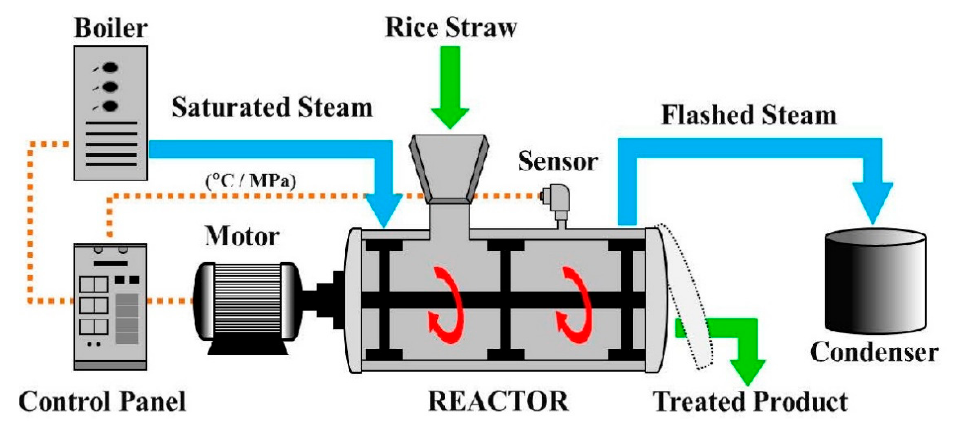
Figure 1. Schematic diagram of the pilot-scale hydrothermal treatment facility.